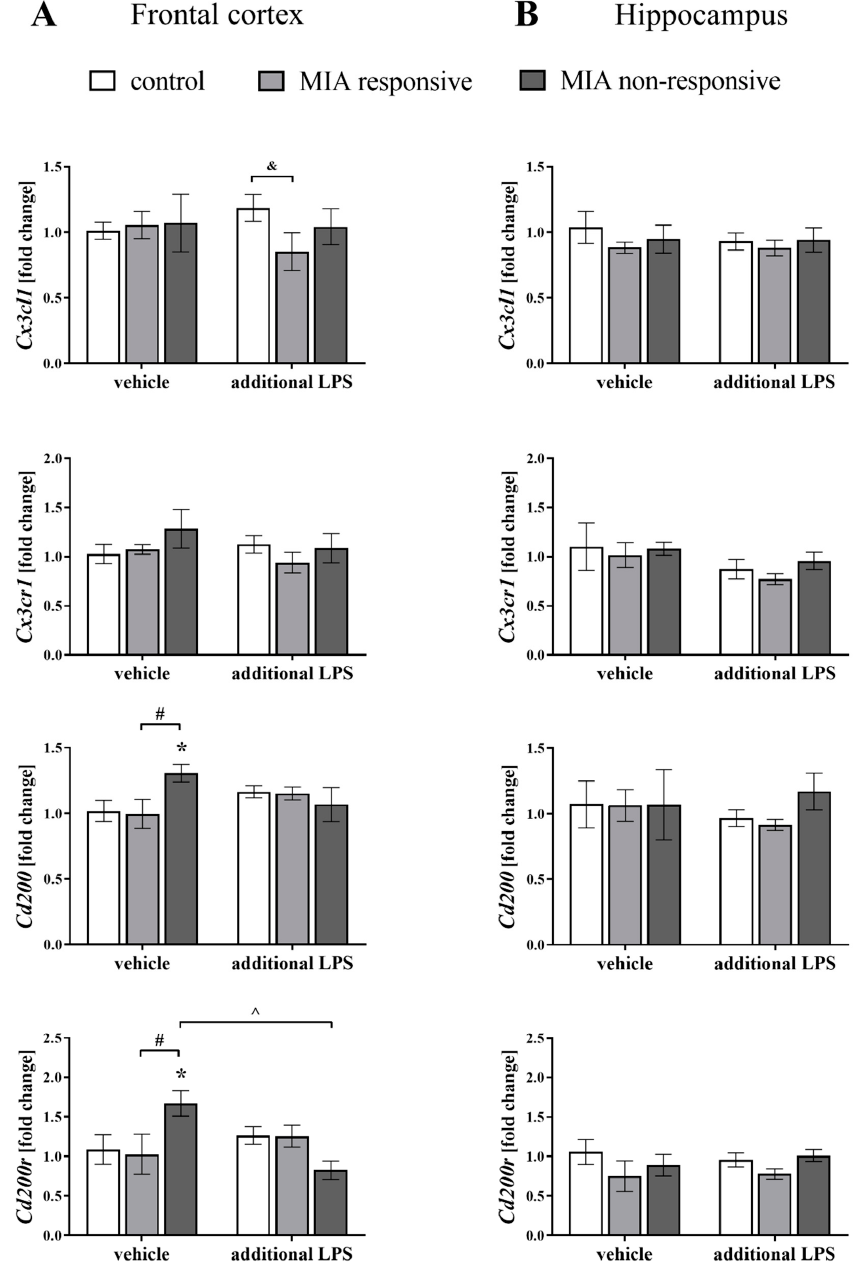
Figure 6. The effect of MIA and the additional acute challenge with LPS on the gene expression of Cx3cl1 , Cx3cr1 , Cd200 and Cd200r in the frontal cortices ( A ) and hippocampi ( B ) of male Sprague-Dawley offspring at PND120. The mRNA levels were measured using qRT-PCR with n = 3–10 in each group. The results are presented as the average fold change ± SEM. * p < 0.05 vs. control + vehicle, # p < 0.05 vs. MIA responsive + vehicle, ^ p < 0.05 vs. MIA non-responsive + vehicle, & p < 0.05 vs. control + LPS.